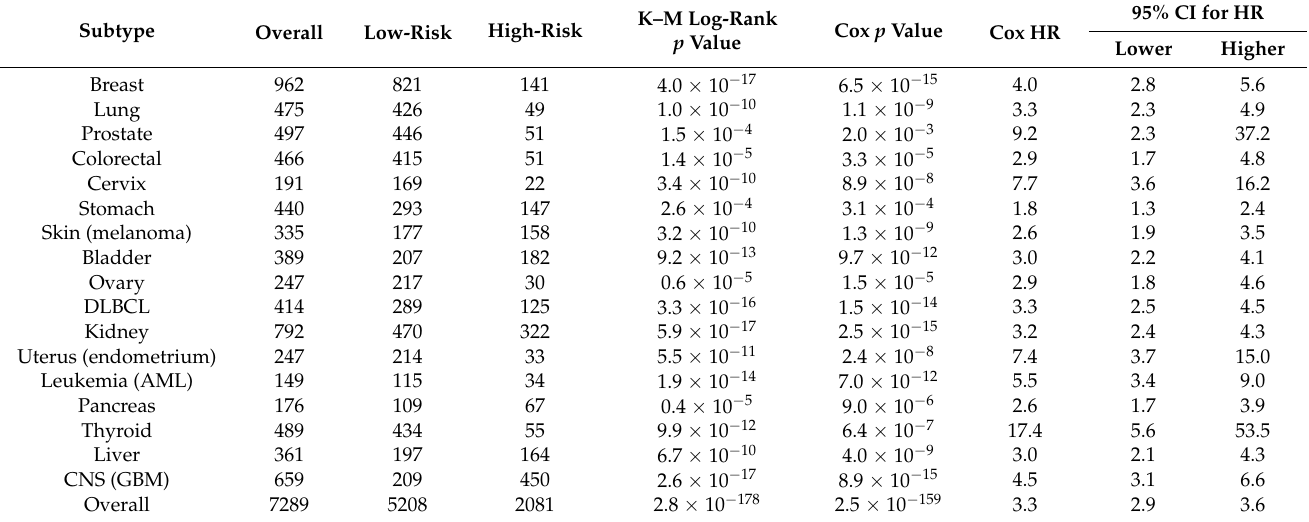
Table A6. Overall survival of the pan cancer series using the risk-scores.